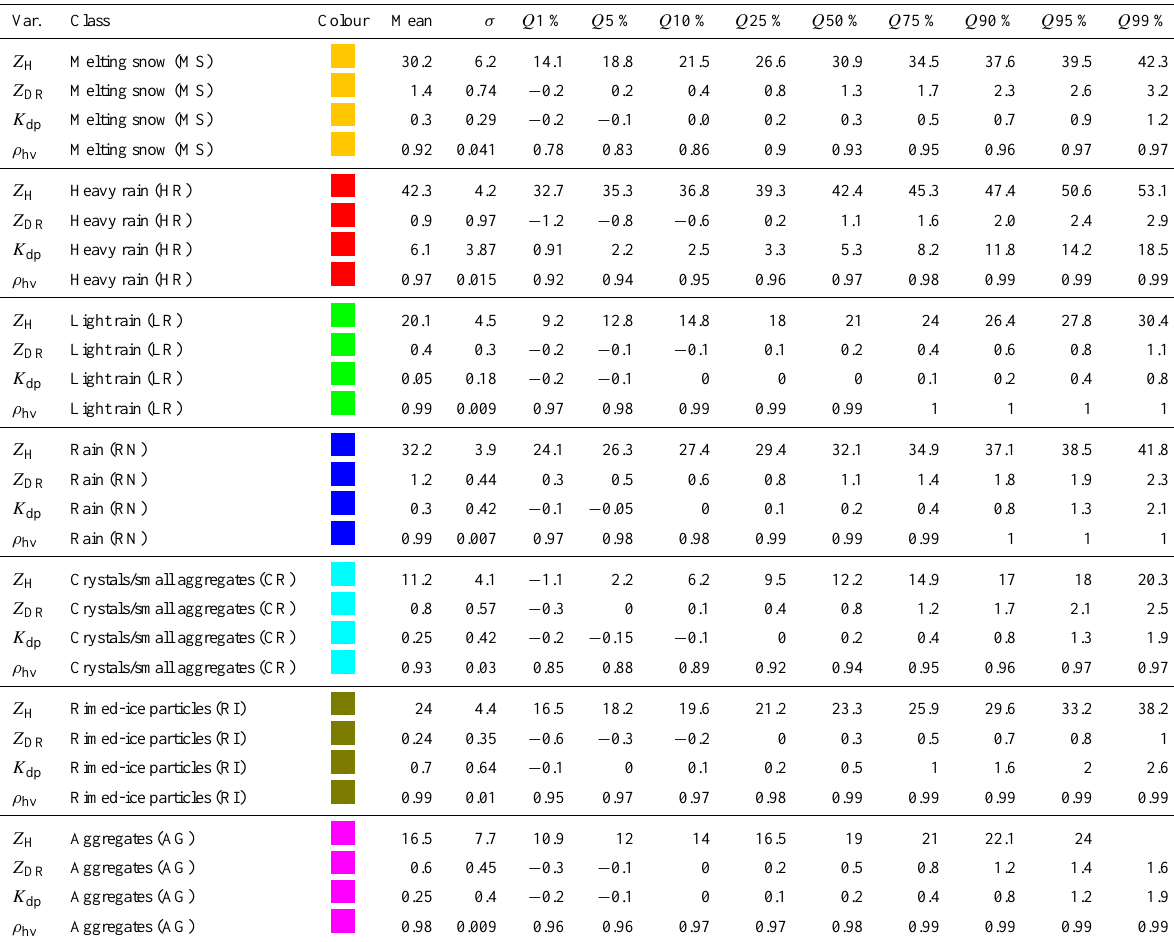
Table A1. Statistics describing the content of the seven clusters identified in Sects. 5 and 6. For each polarimetric variable and for each cluster, we provide the mean value, standard deviation σ , and a set of quantiles ( Q 1%, Q 5%, 10%, Q 25%, Q 50%, Q 75%, Q 90%, Q 95%, Q